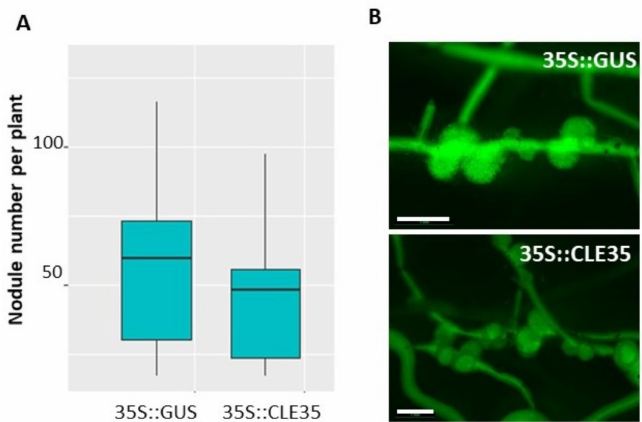
Figure 6. MtCLE35 overexpression does not a ff ect nodulation phenotype in sunn-4 mutant. ( A ) Nodule number on green fluorescent protein (GFP)-positive transgenic roots of sunn-4 plants transformed with the 35S : GUS (control) or 35S :: MtCLE35 construct. Box plots are presented with median values. No statistically significant di ff erences were found between nodule number in 35S : MtCLE35 and 35S : GUS (control) overexpressing plants. ( B ) Examples of the nodulation phenotype of GFP-positive transgenic roots carrying the 35S :: GUS (control) or 35S::MtCLE35 construct on sunn-4 mutant plants. Bars = 1000 µ